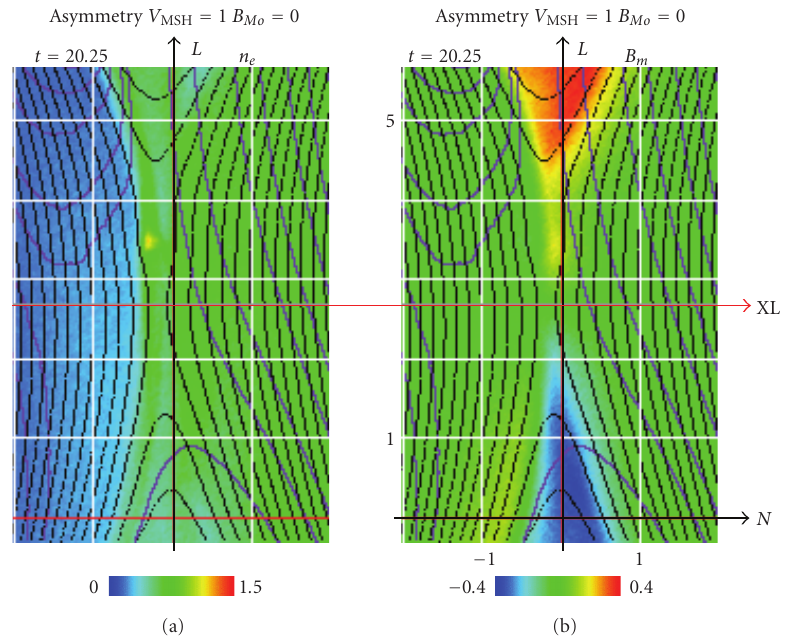
Figure 7: Zooming into the X-line region for the V MSH = 1 and B Mo = 0 case. (a) Density and (b) B M . The black and purple curves are the field lines and the ion streamlines, respectively. The spatial dimension is [ L XL − 3, L XL + 3] × [ N XL − 2, N XL + 2]. The time is t = 20 .